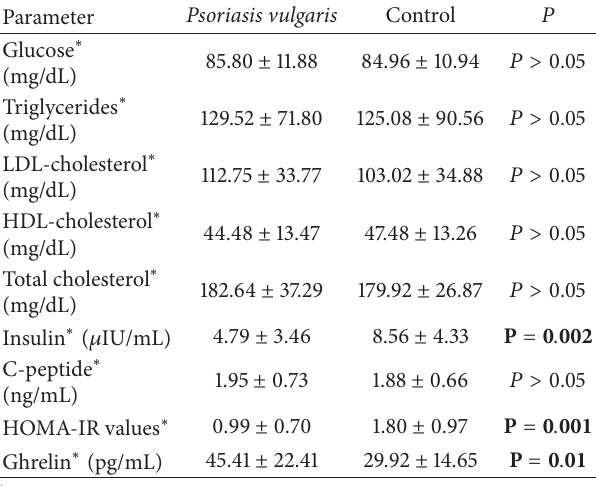
Table 3: Laboratory findings of patient and control